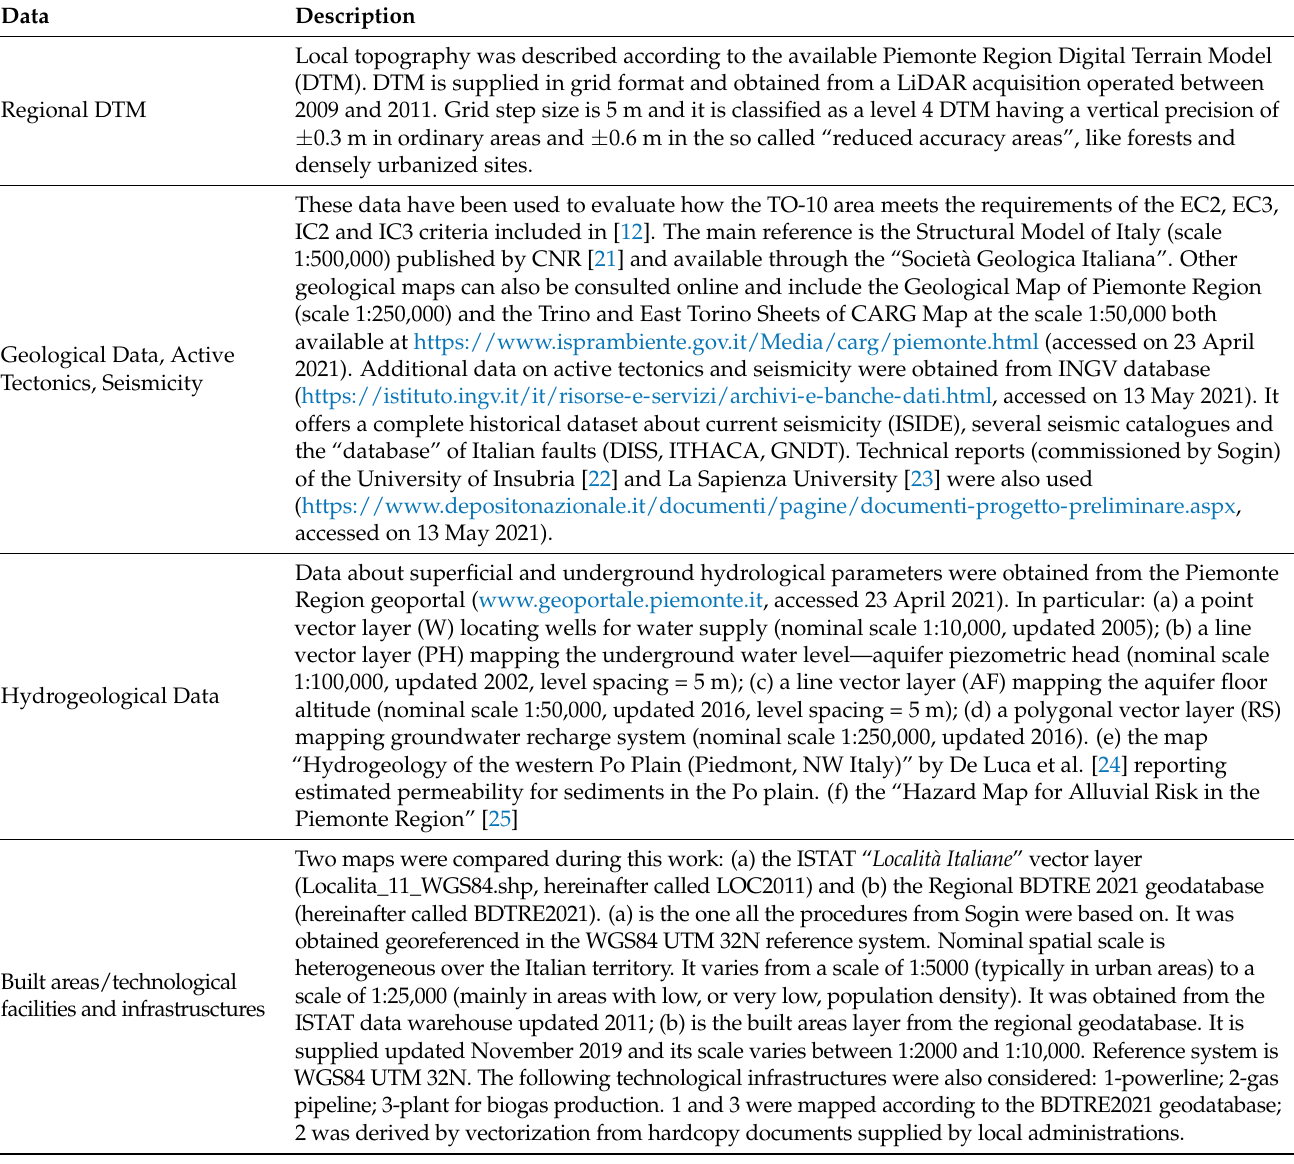
Table 2. Geographical data from open archives used for this